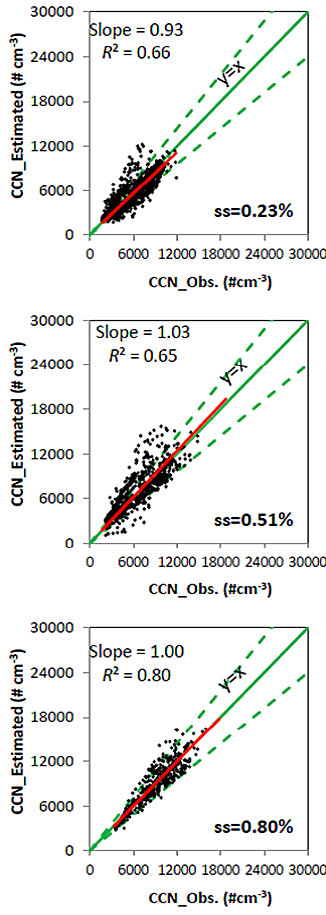
Figure 6. As in Fig. 5, but for the non-parallel observation (NPO) closure test. The dashed green lines indicate the boundaries representing ± 30% deviations of N CCN -estimated from N CCN -